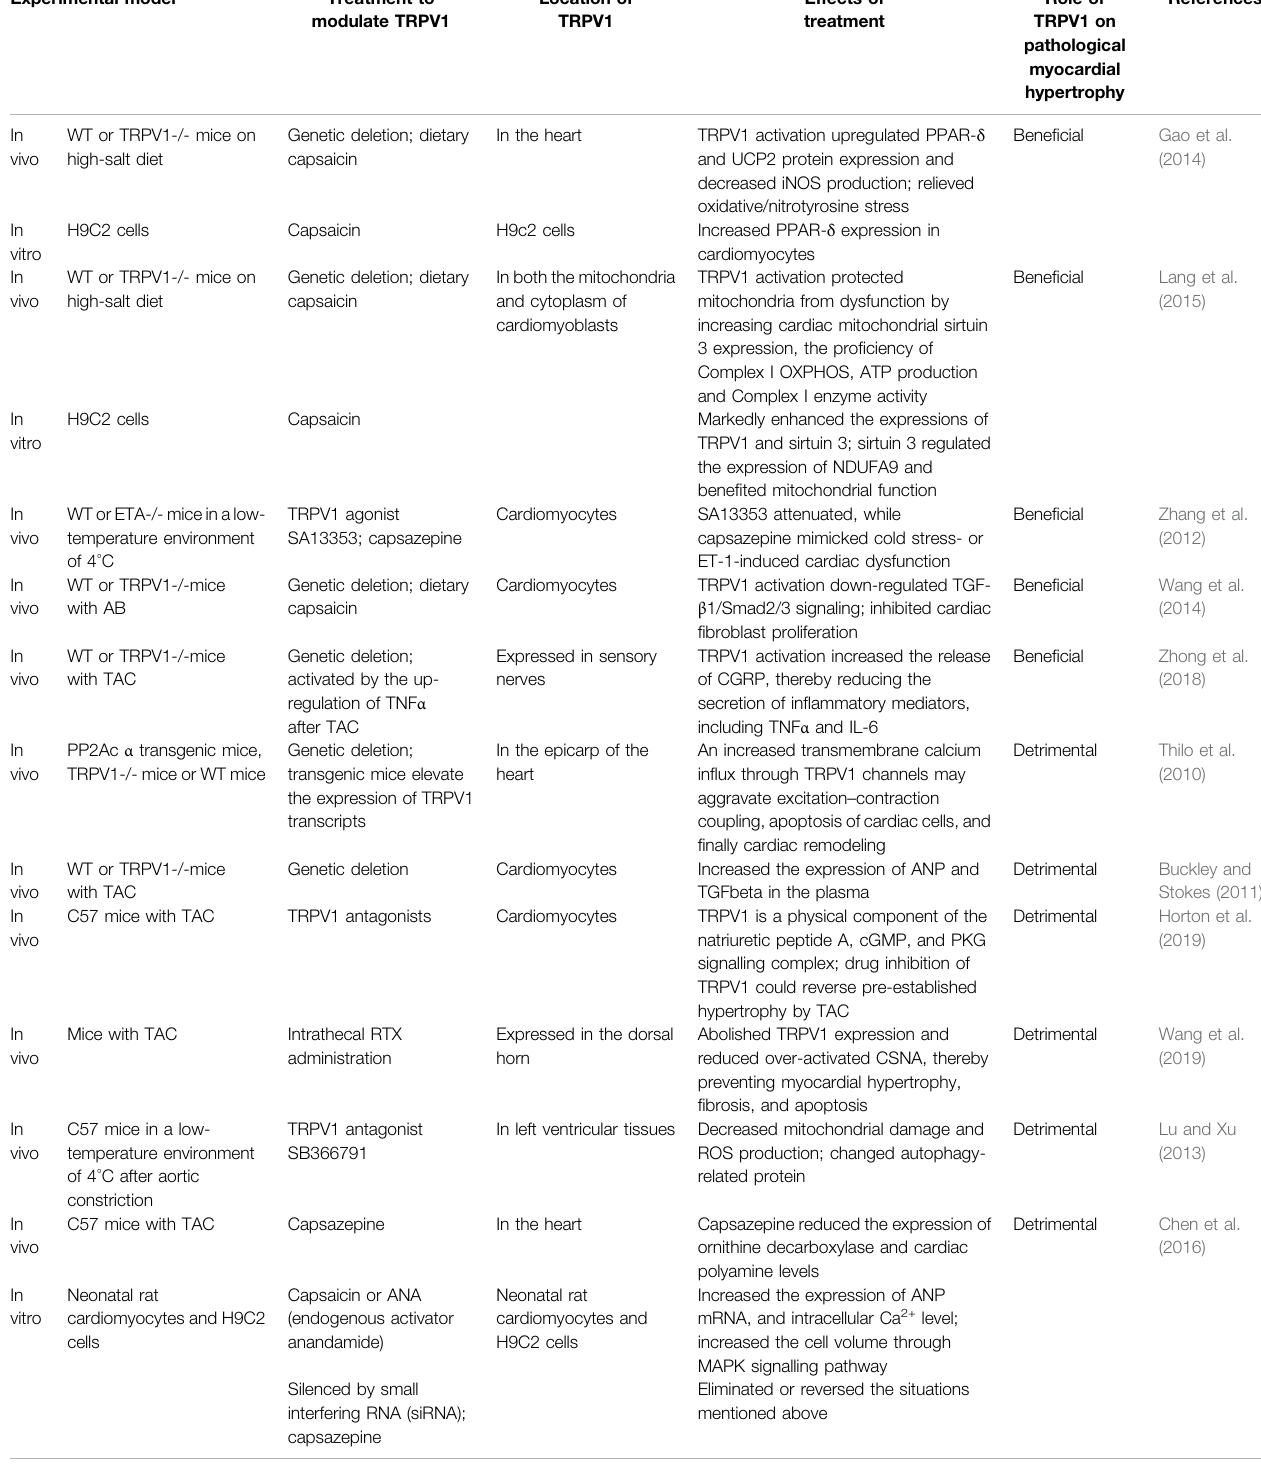
TABLE 1 | Summary for the role of TRPV1 in Pathological Myocardial